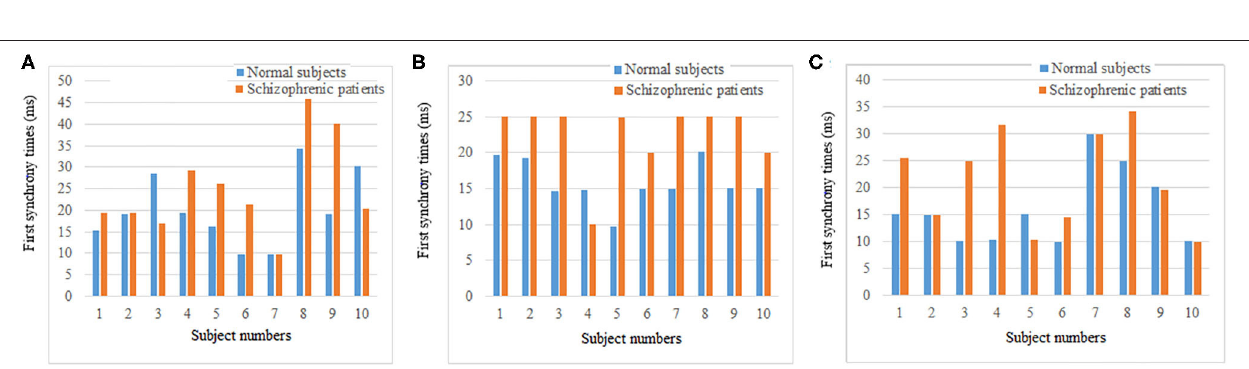
FIGURE 10 | First synchrony time of three stages. (A) Encoding stage, (B) maintenance stage, (C) retrieval stage.